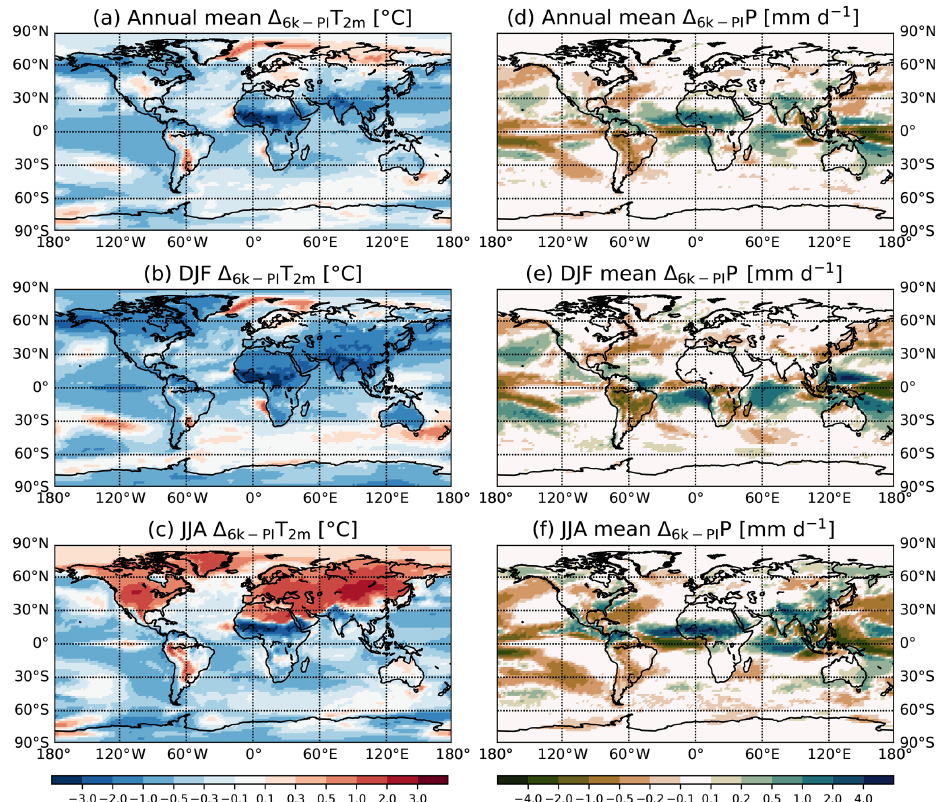
Figure 5. Simulated annual, boreal winter (DJF) and boreal summer (JJA) changes in 2m temperature (a, b, c) and precipitation (d, e, f) between 6k and